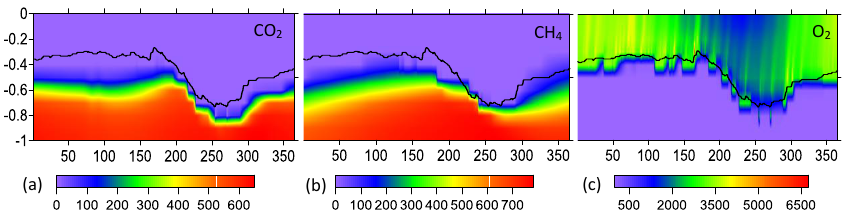
Fig. 8. Time series of (a) simulated daily CH4 flux (mgCm − 2 day − 1 ) from 1999 to 2009, (b) simulated growing season (day of year 120 to 330) daily CH4 flux (mgCm − 2 day − 1 ) from 2004 to 2008 (blue area indicates the variation range as recorded for the Mer Bleue Bog averaged from 12 collars (Moore et al., 2011, Fig. 2), (c) relationship between the simulated growing season daily, and (d) annual average Figure 9. Simulated profiles of dissolved CO 2 (a), dissolved CH 4 (b), and dissolved O 2 (c) concentration (units: (umol·L -1 ) in soil pore water in the year 2002. The black lines indicate water table depth (m).